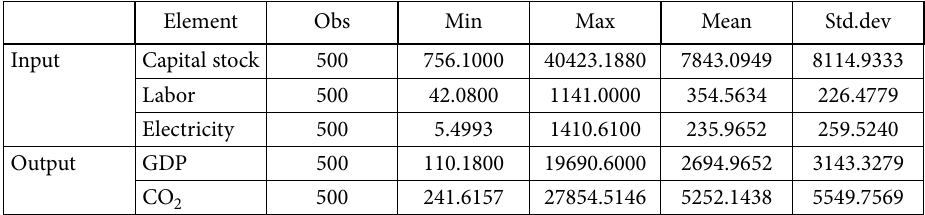
Table 3. Statistical description of output and input variables in 50 cities during 2005–2014 Element Obs Min Max